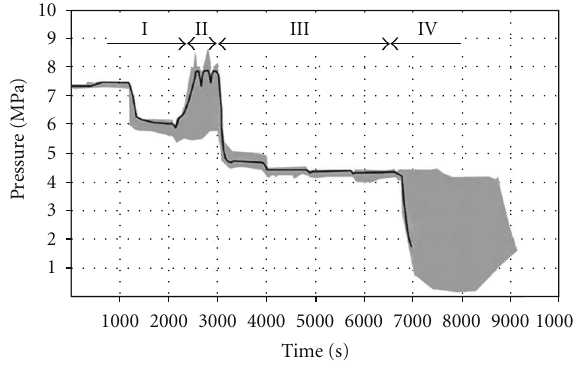
Figure 3: Example of ISP-33 results, primary pressure in experi- ment (solid line) and variation in ISP-33 posttest calculations (gray area). Flow conditions: (I) one-phase flow, (II) flow stagnations, (III) two-phase flow, and (IV) boiler condenser mode, [2].